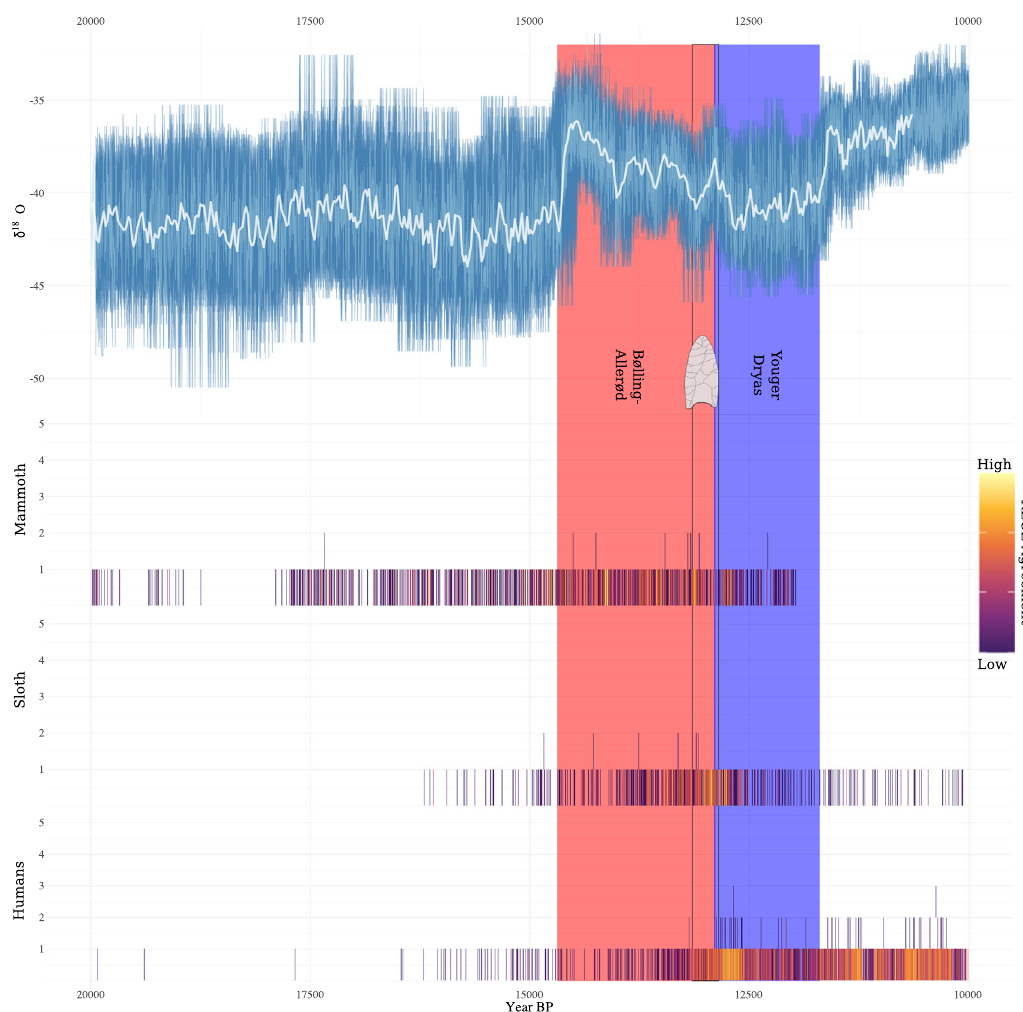
Fig. 9 Climate, mammoth population and sloth population changes through time in the American Southwest (SW). Annual NGRIP oxygen isotope ( δ 18 O) record with temporal uncertainty re-projected into the measurement domain (top) and Radiocarbon-dated Event Count Ensembles (RECEs) for mammoth and sloth for the Southwest region (bottom). For more details see Fig. 5